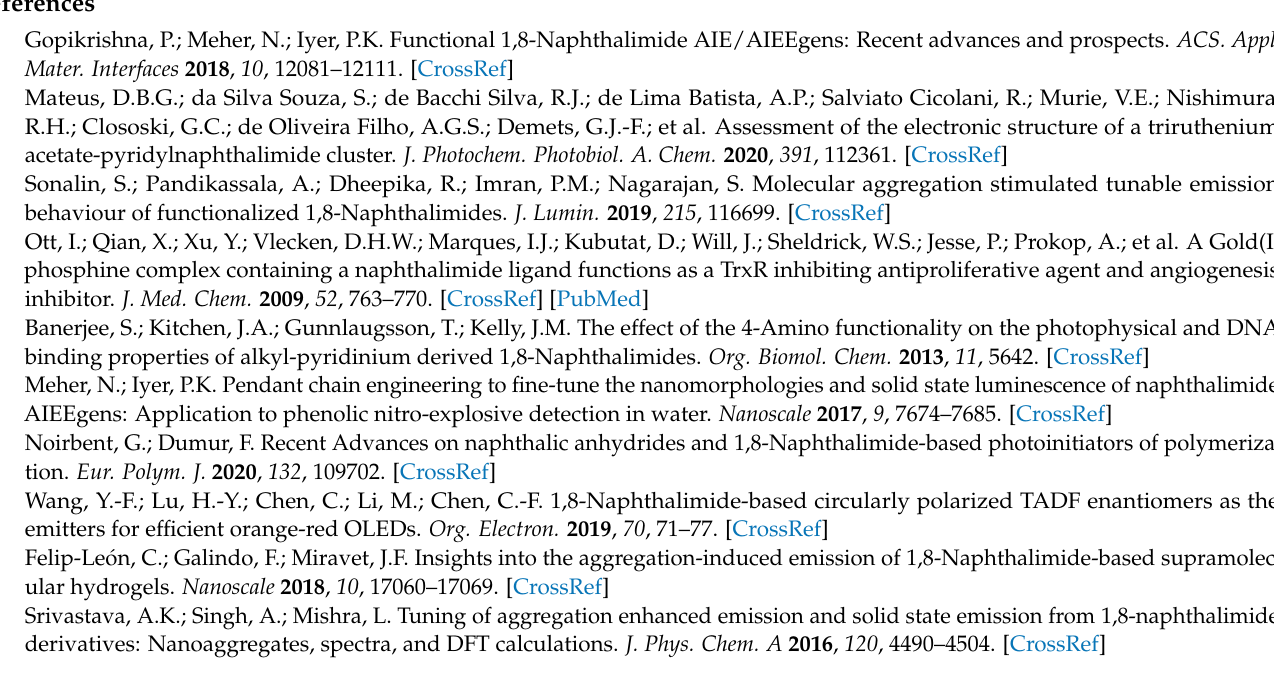
Figure S31: 1 H NMR spectra in DMSO- d 6 of 2 , phenantrene and 1:1 adduct 2: phenantrene, Scheme S1: Experimental procedure for the synthesis of L , Scheme S2: Schematic representation of the possible rationalization of the different steps of the host:guest interaction and resulting